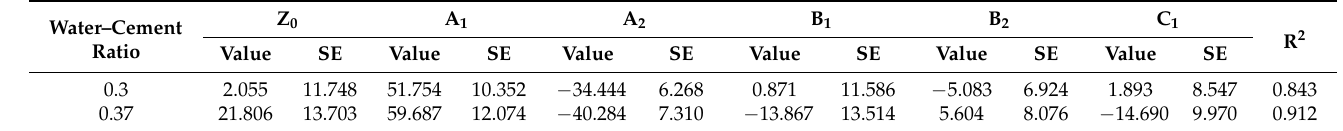
Table 4. Prediction equation fitting of 28-day concrete in compressive